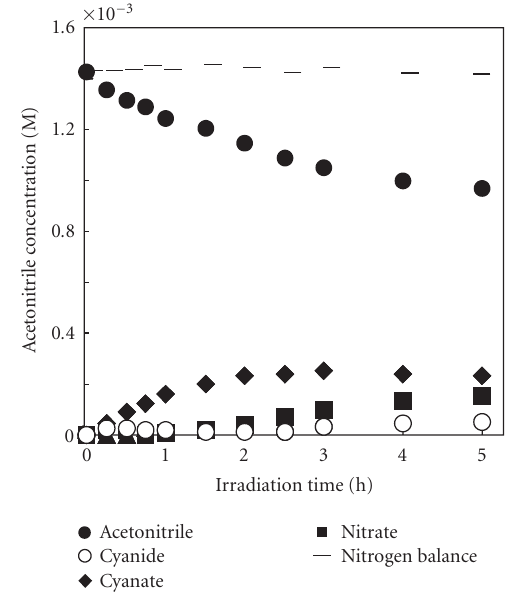
Figure 9: Acetonitrile photocatalytic degradation in liquid-solid regime: concentrations of acetonitrile ( ), cyanide ( (cid:3) ), cyanate ( (cid:3) ), nitrate ( (cid:2) ), and nitrogen balance (–) versus irradiation time. Catalyst: TiO 2 Degussa